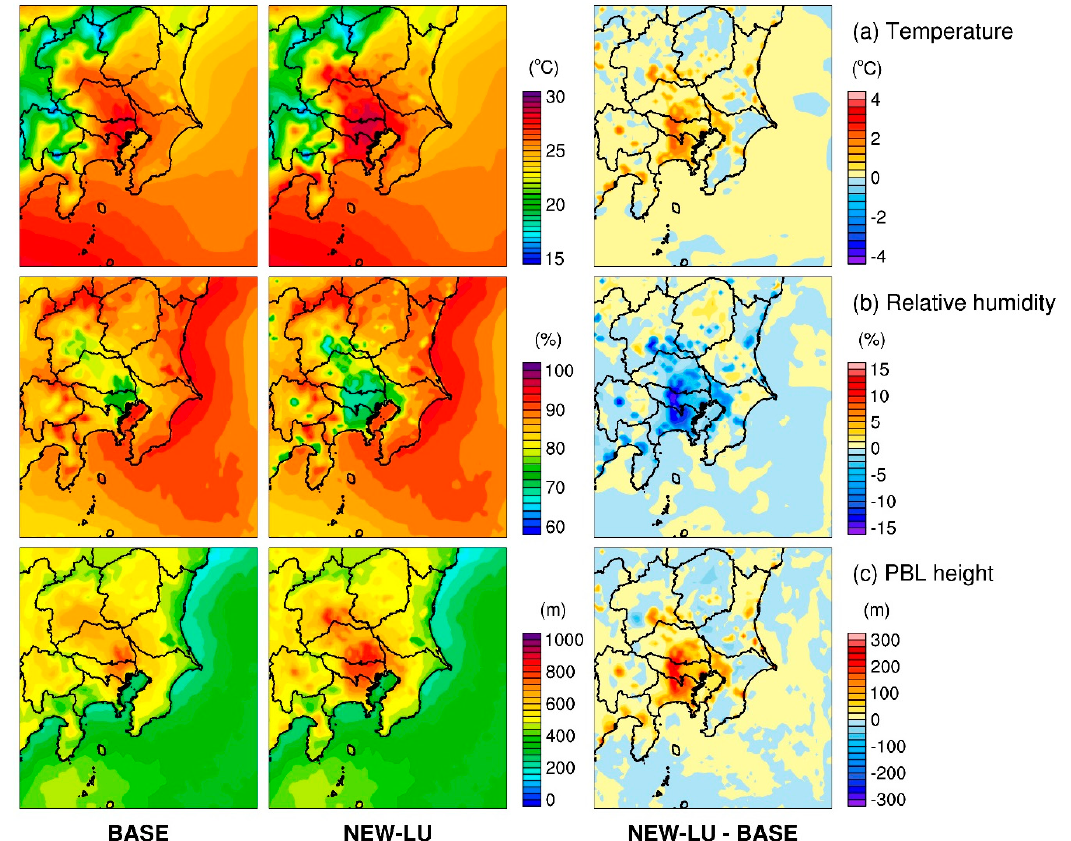
Figure 3. Horizontal distributions showing ( a ) mean temperature at 2 m height; ( b ) relative humidity at 2 m height; and ( c ) PBL height simulated in BASE and NEW-LU cases during the target period in d04.